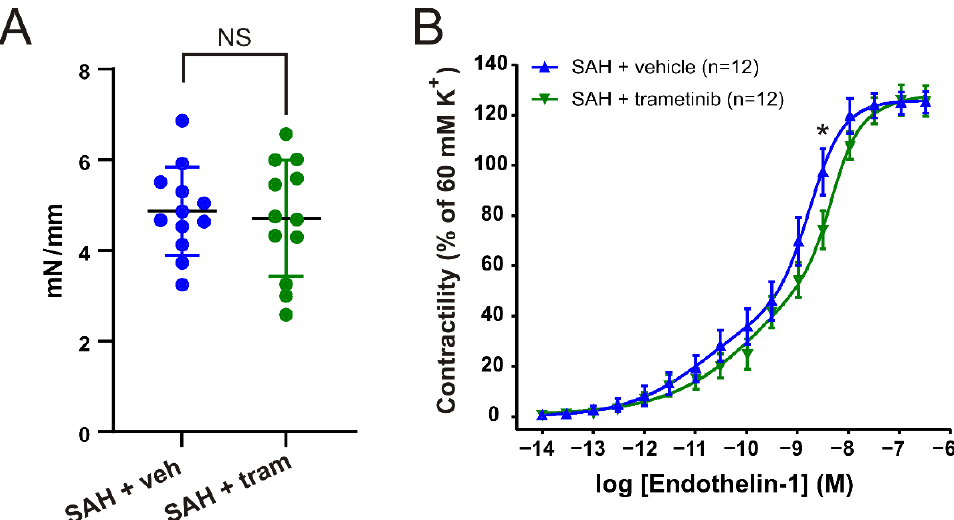
Figure 3. Comparison of trametinib and vehicle treatment on contractility in the BA. ( A ) Maximal contraction to 60 mM K + for the BAs. ( B ) Cumulative concentration – response curves to ET-1 (10 −14 – 10 −7 M) on the BA. Data are shown as mean ± SEM, with statistics calculated using two-way ANOVA followed by Bonferroni post-test, * p < 0.05.